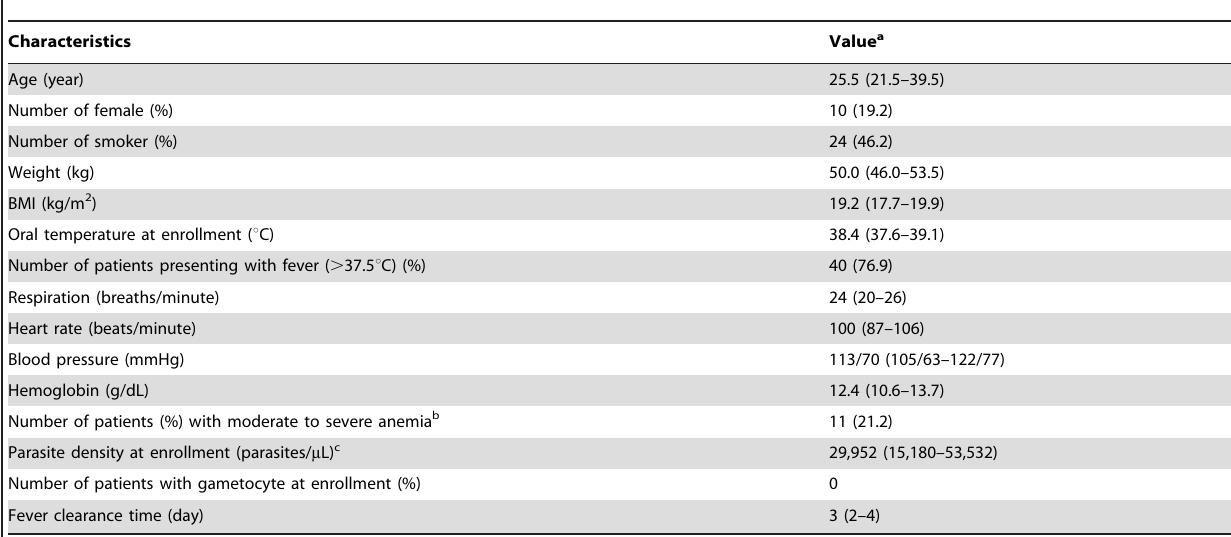
Table 1. Baseline characteristics of study participants (N